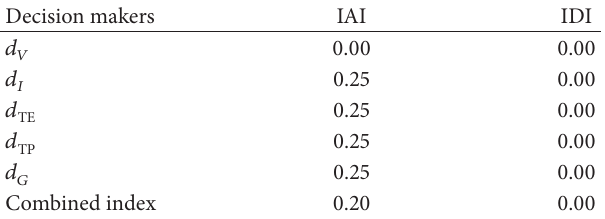
Table 5: Software evaluation